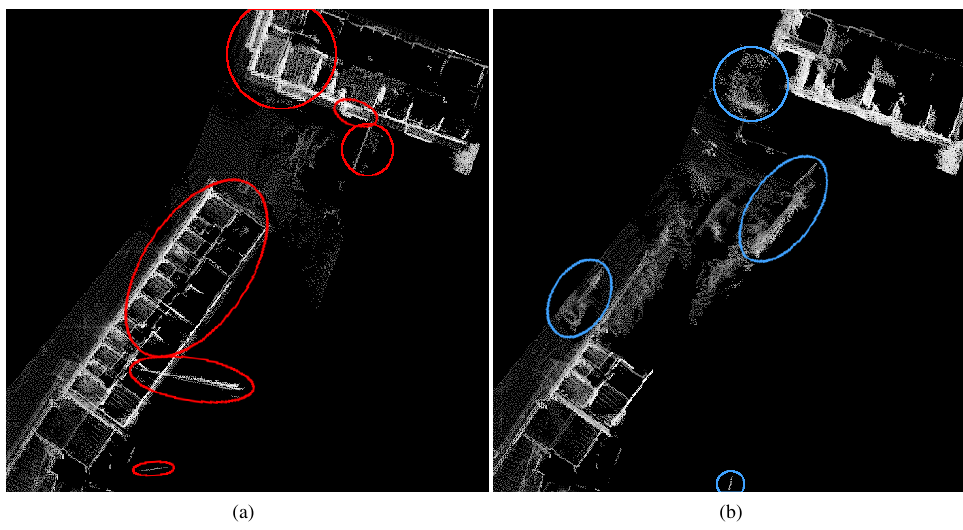
Figure 5. Overview over the point clouds of (a) epoch 1 and (b) epoch 5. Red circles imply disappearances, blue circles appearances. The heatmap in 6(c) shows the locations observed in epoch 1, but not again in epoch 5. The area at location marker M1 has re- mained unobserved because the path of the measurement vehicle in epoch 5 deviates strongly from its previous path in epoch 1.